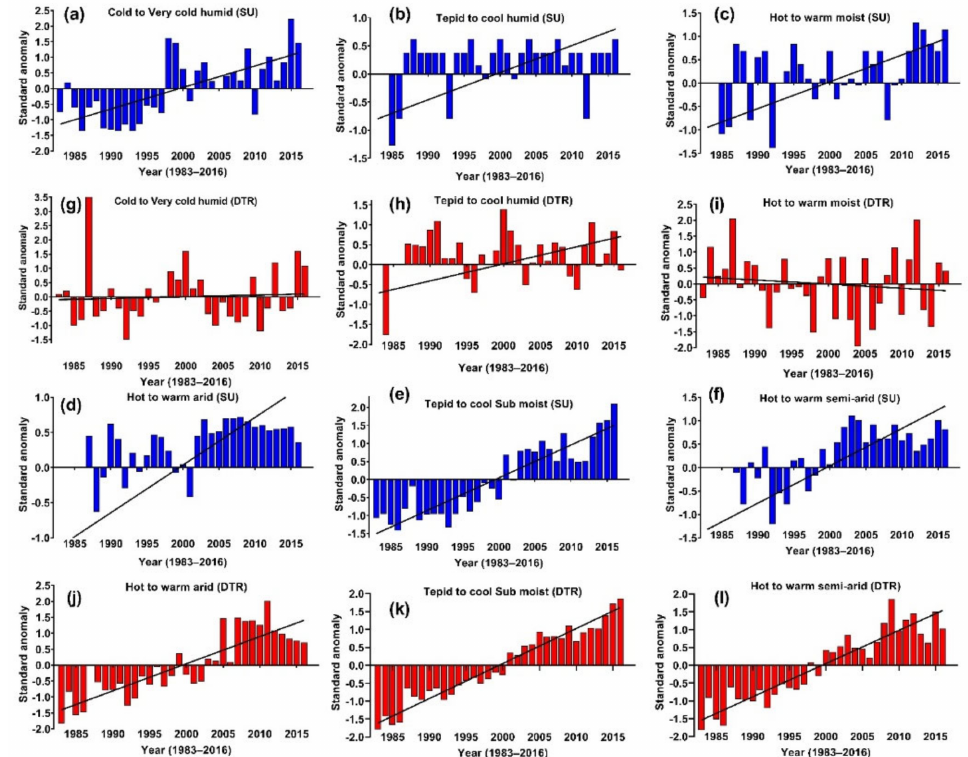
Figure 7. Number of summer days (SU) ( a – f ) and Diurnal temperature range (DTR) ( g – l ) over agroecological zones for the period